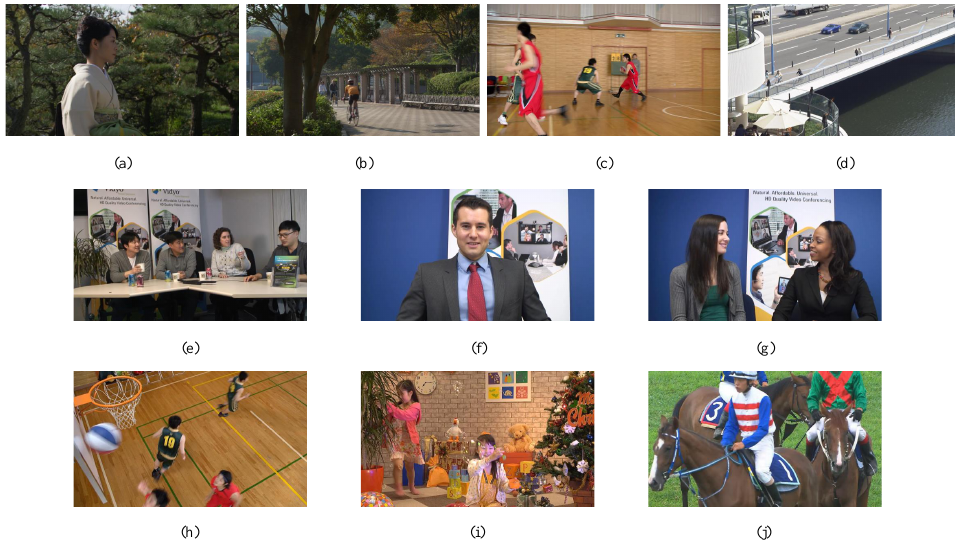
Figure 13. The HEVC standard test sequences. ( a ) Kimono1; ( b ) ParkScene; ( c ) Basketball Drive; ( d ) BQTerrace; ( e ) FourPeople; ( f ) Johnny; ( g ) KristenAndSara; ( h ) Basketball Drill; ( i ) PartyScene; ( j )